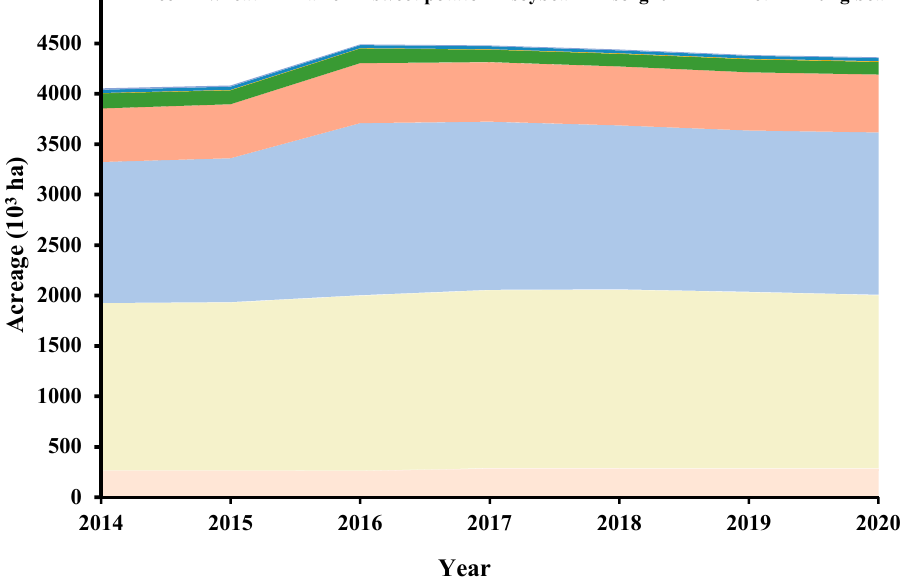
Figure 2. Planting area of main crops in the Huang-Huai-Hai farming region from 2014–2020.